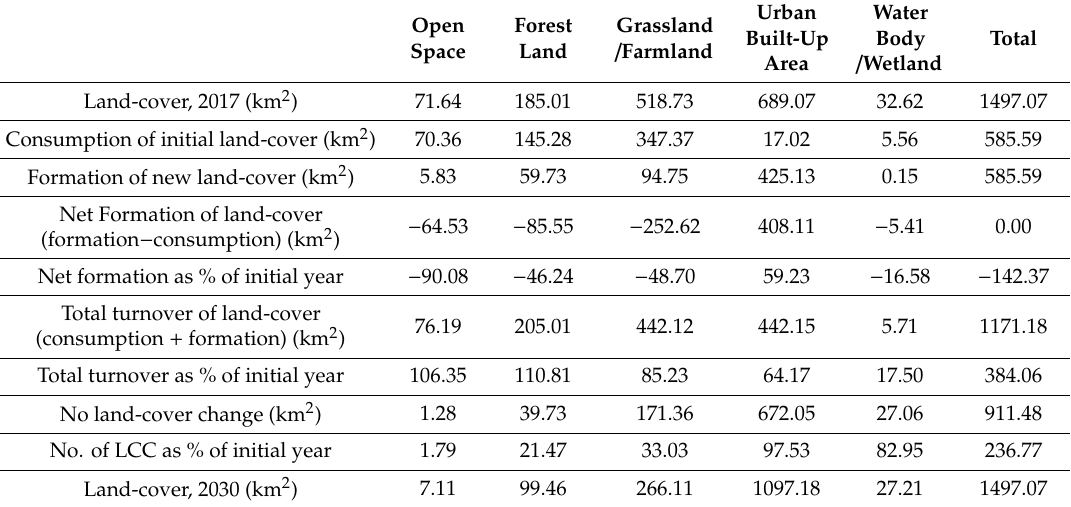
Table 3. Predicted land-cover account for GAMA,